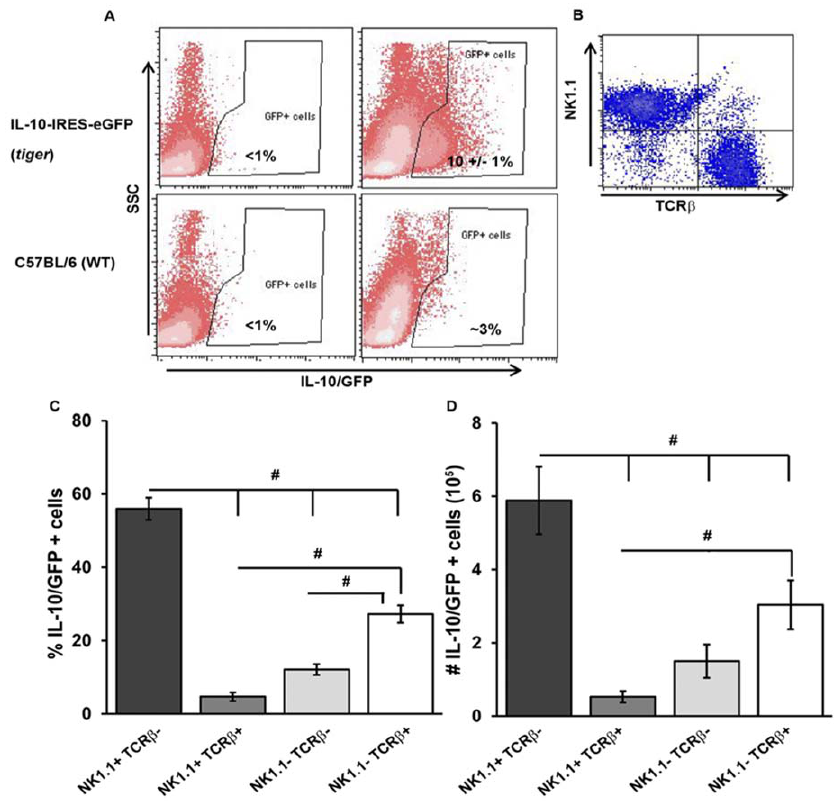
Figure 2. Characterization of IL-10 expressing cells in liver after MCMV infection. Liver leukocytes were prepared from IL-10-IRES-eGFP reporter ( tiger ) mice that were left uninfected (D0) or infected with MCMV for 4 days (D4). (A) The gating strategy defining IL-10/GFP positive cells by flow cytometric analysis is shown. Representative plots show the proportions of IL-10/GFP + leukocytes after FSC/SSC gating of leukocytes and gating on IL-10/GFP + events in relation to side scatter. D0 and D4 infected C57BL/6J (WT) mice were included to control for background fluorescence. (B) Representative plot shows NK1.1 and TCR b expression within total IL-10/GFP + liver leukocytes in day 4 infected tiger mice. (C and D) The frequency and total numbers of IL-10/GFP + populations are shown as the means 6 SE and are combined data from three independent experiments (n=11 mice total). The statistical differences between IL-10/GFP + groups were determined by one way ANOVA, followed by Tukey’s multiple comparisons post hoc test. ‘‘ # ’’ indicates a p value of # 0.05. The following comparisons were significant: NK1.1 + TCR b 2 vs. NK1.1 + TCR b + , NK1.1 2 TCR b 2